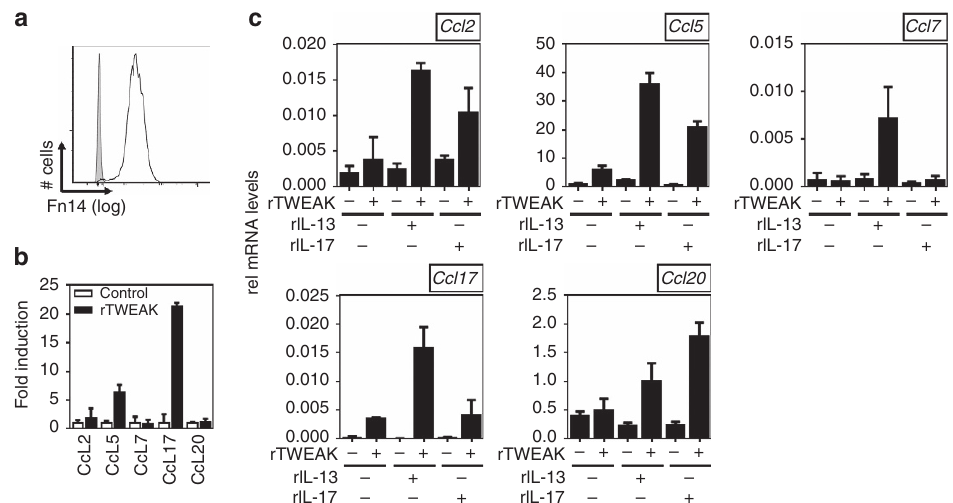
Figure 5 | TWEAK synergizes with IL-13 and IL-17A to induce chemokines in human keratinocytes. ( a ) Basal surface expression of Fn14 (line) on NHEK cells relative to Isotype staining (grey). ( b , c ) NHEK cells were stimulated for 48h with rTWEAK, rIL-13, rIL-17 or their combination. mRNA expression of indicated chemokines was assessed relative to GAPDH. Means of triplicate cultures with standard deviations. Values were compared using Student’s t -test. One out of three independent